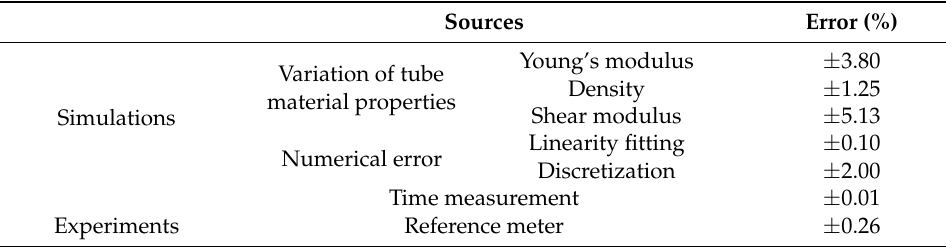
Table 4. Errors for simulations and